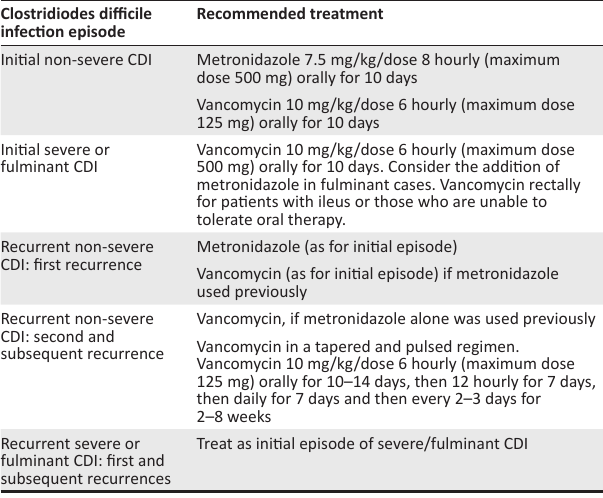
TABLE 5: Recommended treatment options for Clostridioides difficile infection in the paediatric population. Clostridiodes difficile infection